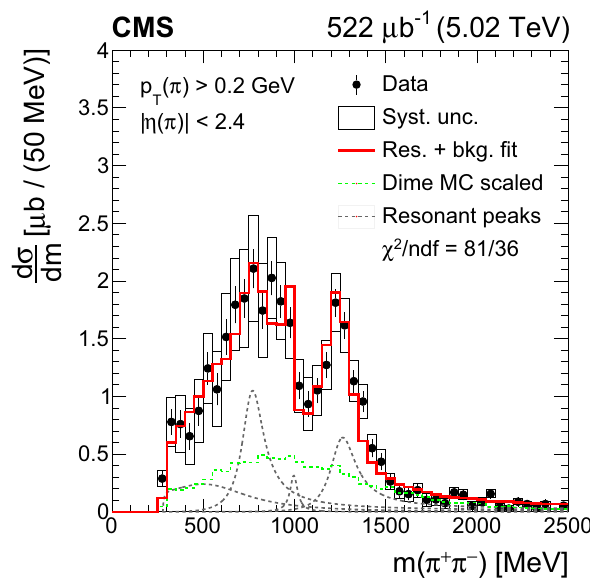
the 5.02 (left) and 13TeV (right) data sets. The error bars correspond to statistical, whereas the open boxes correspond to systematic uncer- tainties